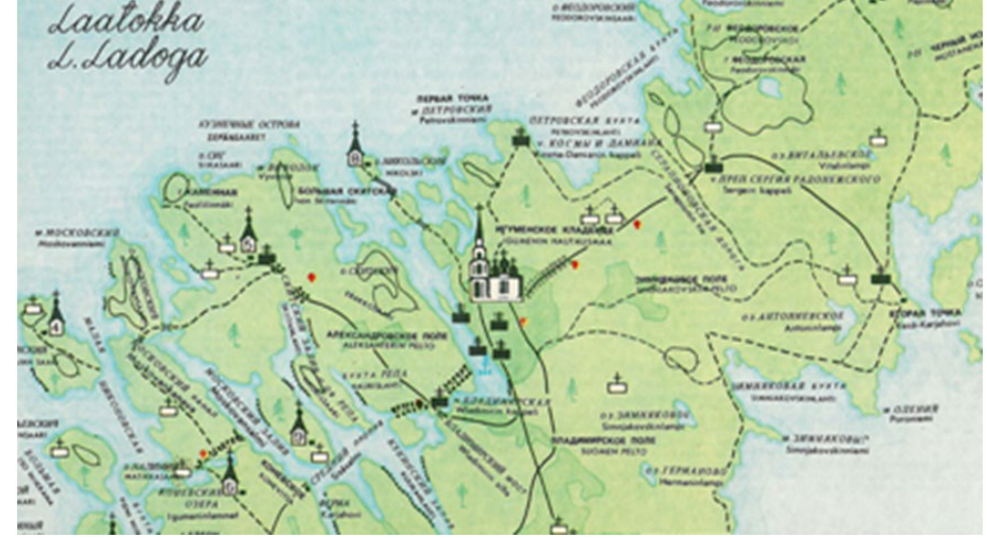
Figure 3 – Map of Valaam with double names in Russian and Finnish languages [9]